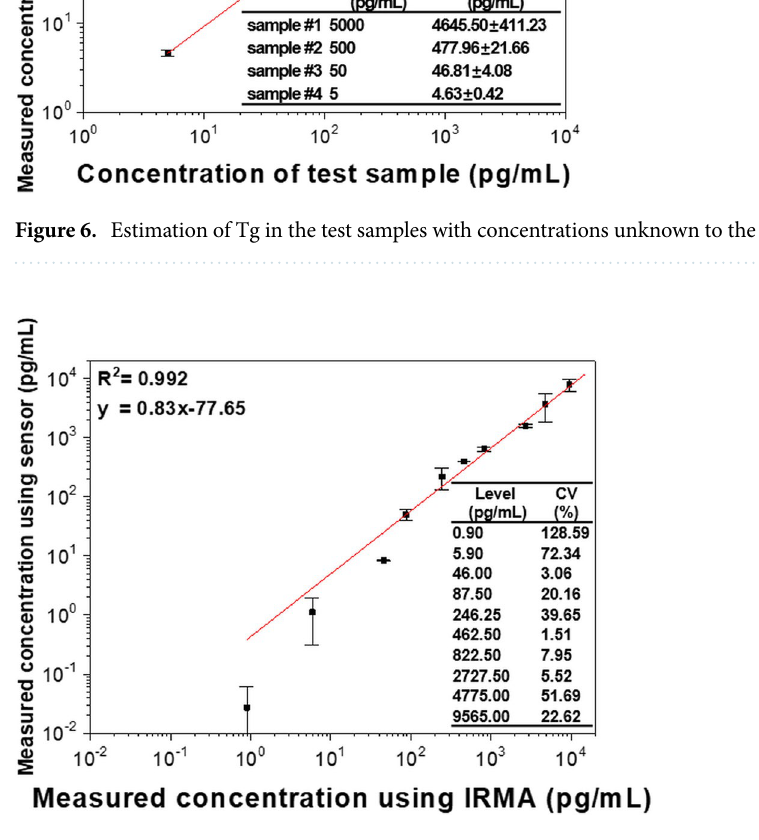
Figure 7. Correlation test between obtained Tg concentrations by the FO LSPR sensor chip and commercial